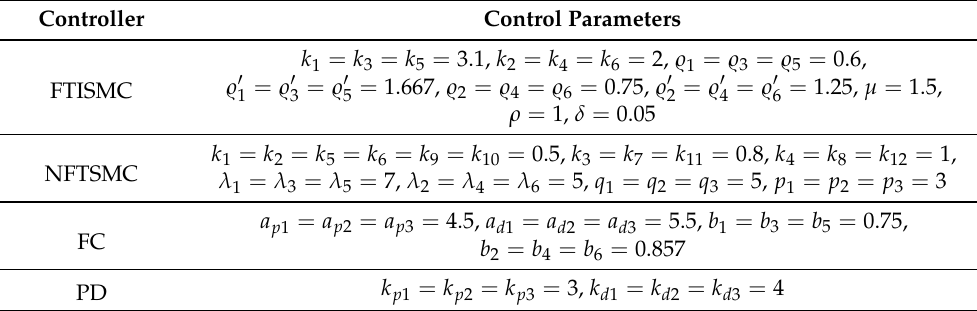
Table 2. The control parameters in the